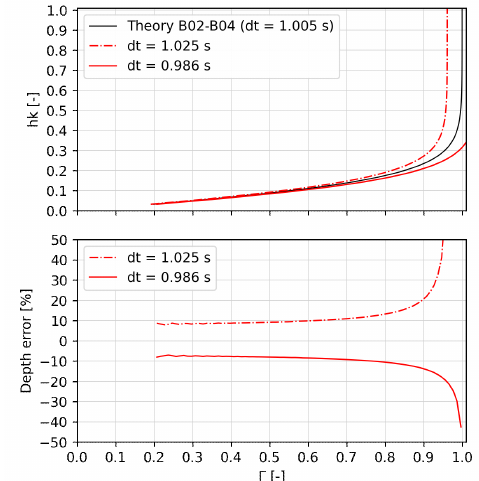
Figure 21: Error extremes for a depth inversion using the linear dispersion relation for free surface waves in relation to an inaccurate